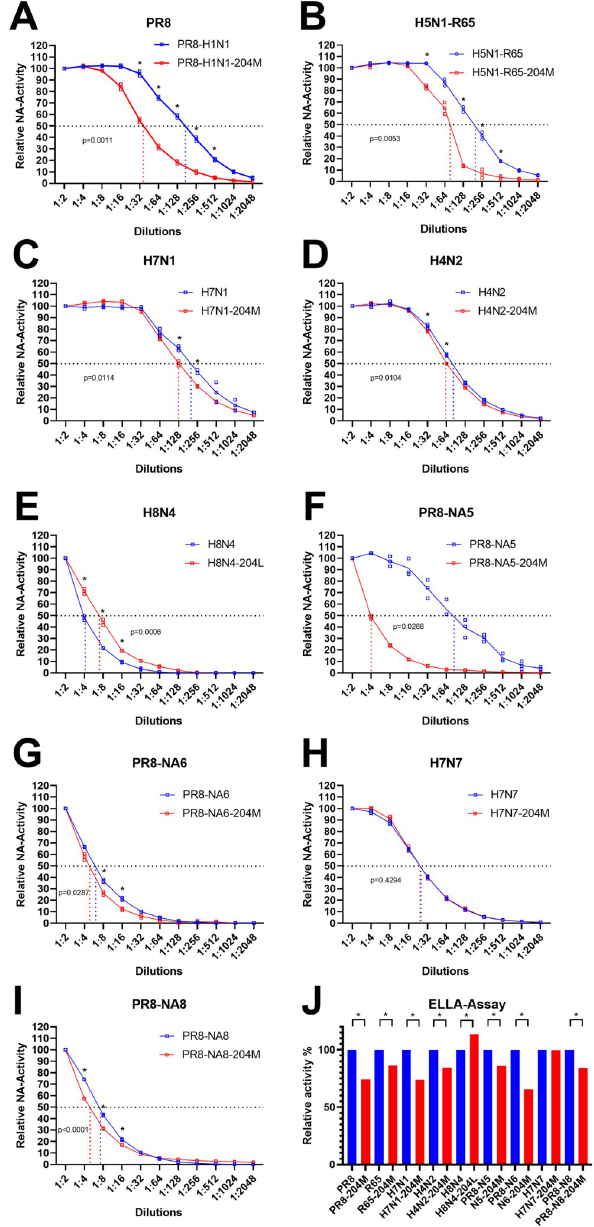
Fig 3. The impact of L204M mutation on NA activity of different subtypes of influenza viruses. Shown is the specific impact of L204M mutation on NA activity of different subtypes of influenza viruses carrying group 1 and group 2 NA against small substrate MUNANA (A-I) and large substrate fetuin (J). PR8-NA5, PR8-NA6 and PR8-NA8 were generated using seven gene segments from PR8 and NA from clade 2.3.4.4 H5N5, H5N6 or H5N8, respectively (see S1 Table). Viruses were adjusted to 32 HA units using chicken erythrocytes. The p-values shown in the graphs refer to the statistical significance of the 50% NA-activity (shown as dashed lines) of different 204-mutants compared to the wild-type viruses (A-I). The activity of different L204M-carrying viruses against fetuin in ELLA assay was calculated relative to the same virus dilution of the wild type viruses. Asterisks refer to statistical significance at p value < 0.05 as indicated (A-I) or compared to the NA activity of the wild type viruses in each subtype (J). ELLA-Assay was done in three independent runs and the results are expressed as mean and standard deviation of all replicates (black